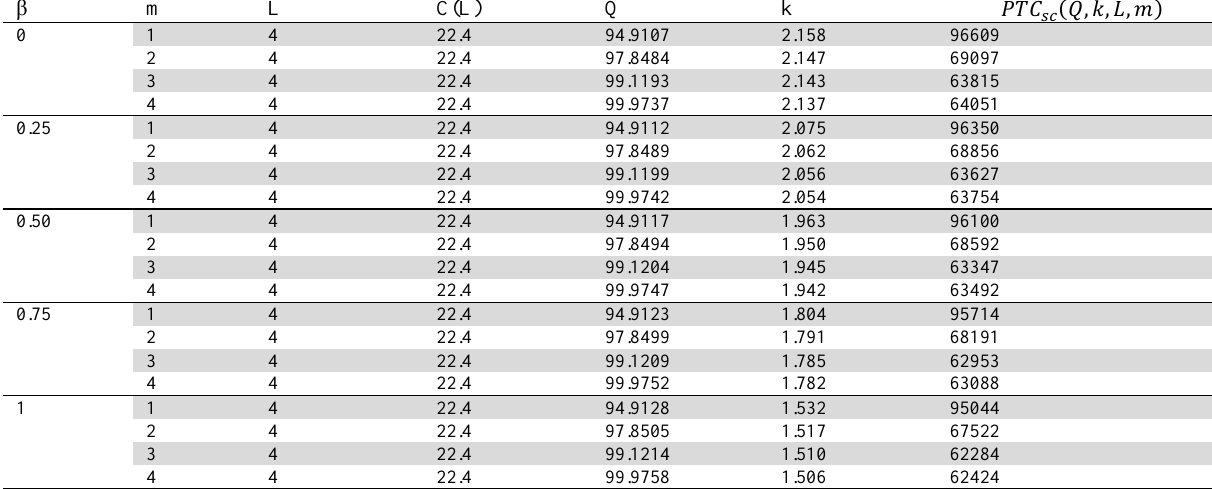
Solution procedures for numerical example 1 β